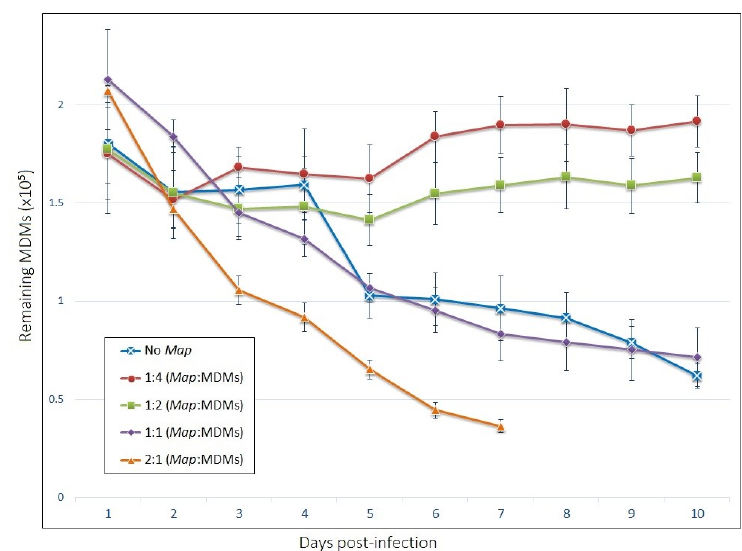
Figure 3. The viability of host MDMs in our model depends on the multiplicity of Map exposure. The number of adherent cells remaining by day post-infection. The bars are standard deviation (n = 4).